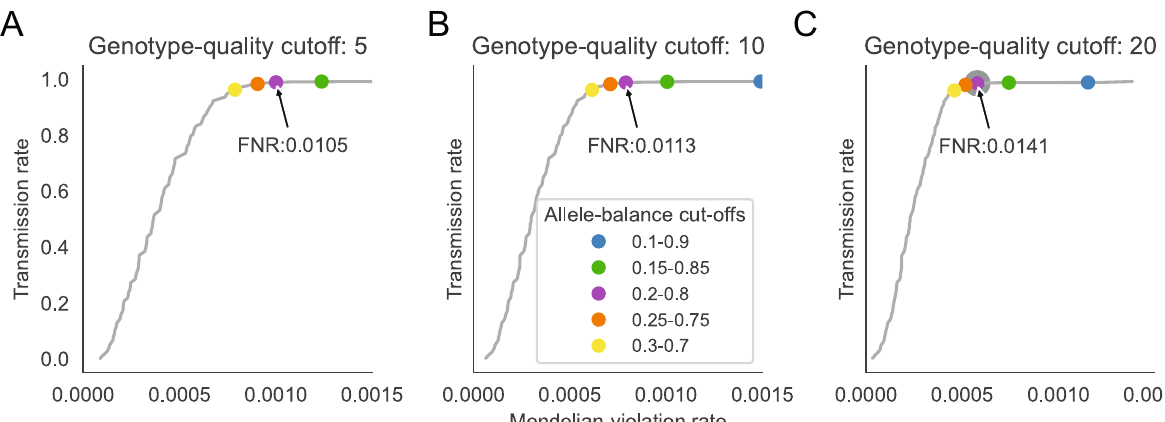
Fig. 1 Evaluation of the impact of allele-balance and genotype-quality cutoffs on Mendelian violation rates for trio exomes. We measured the number of Mendelian violations ( x -axis) and transmissions ( y -axis) as we varied allele balance within each plot. The genotype-quality cutoff applied is increased from 5 ( A ) to 10 ( B ) to 20 ( C ) for each plot. The line in each plot is drawn by varying the allele-balance cutoff and counting the number of variants that are predicted to be transmitted or apparent Mendelian violations. Dots in each plot indicate the exact rates at a given threshold. The chosen cutoff, marked with an asterisk, required a genotype quality 20 and an allele balance between 0.2 and 0.8. The false negative rate (FNR) for the allele-balance cutoff of 0.2 – 0.8 (in purple) is annotated for each genotype-quality